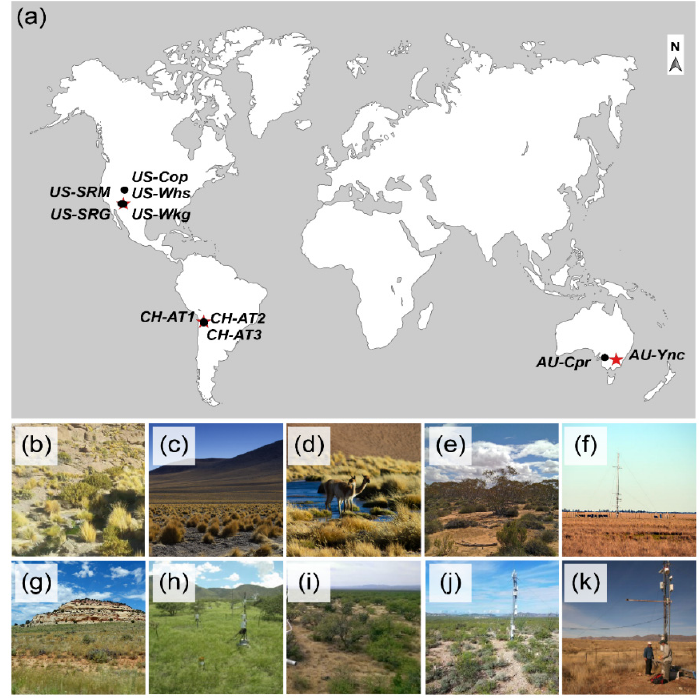
Figure 1. ( a ) Location of study sites, where red stars correspond to the sites used to validate actual evapotranspiration (ET a ) estimates. The bottom of the figure shows pictures of the environment of the study sites; ( b ) CH-AT1 [51], ( c ) CH-AT2 [51], ( d ) CH-AT3 [51], ( e ) AU-Cpr [48], ( f ) AU-Ync [49], ( g ) US-Cop [40], ( h ) US-SRG [42,52], ( i ) US-SRM [43,53], ( j ) US-Whs [44,54] , and ( k ) US-Wkg [45]. The latitude, longitude, and elevation of each study site are presented in Table 1. Table 2. Period of measurements, sensor height, dominant vegetation type, and approximate vegetation height of each site [39–45,51]. The country of each site is coded as follows: Chile (CH), Australia (AU), and the United States (US). Time Period Site Sensor Height (m) Dominant Vegetation